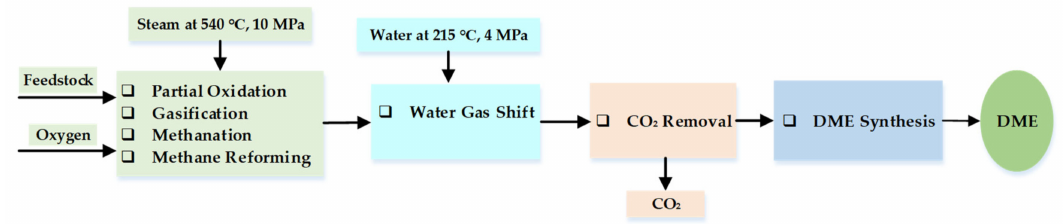
Figure 10. Schematic diagram of the DME production process. Adapted from [194]. Developed by the authors.